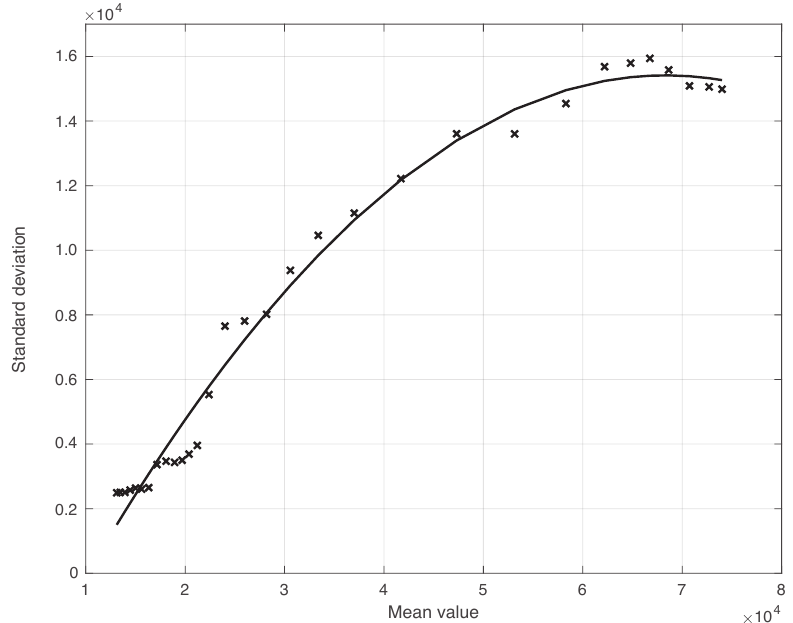
Figure 7. Standard deviation of the local fluctuations of the real SARS-CoV-2 Italian positive test sequence from 7 December 2021 to 6 January 2022, as a function of their expected value. The continuous line represents the best fit with a degree 2 polynomial